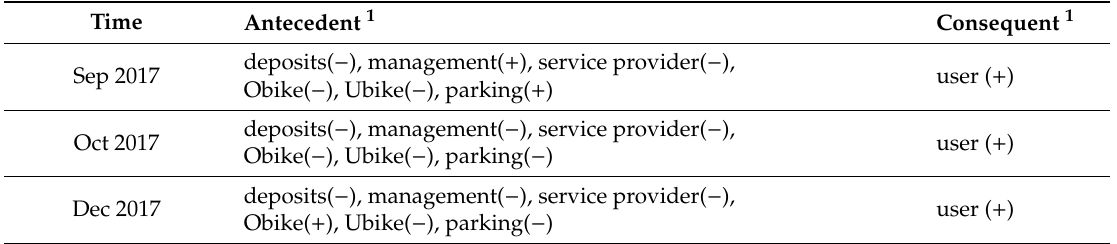
Figure 11. Keyword frequency of the antecedent “parking”. Table 5. The time when the consequent “user” was in the higher range of